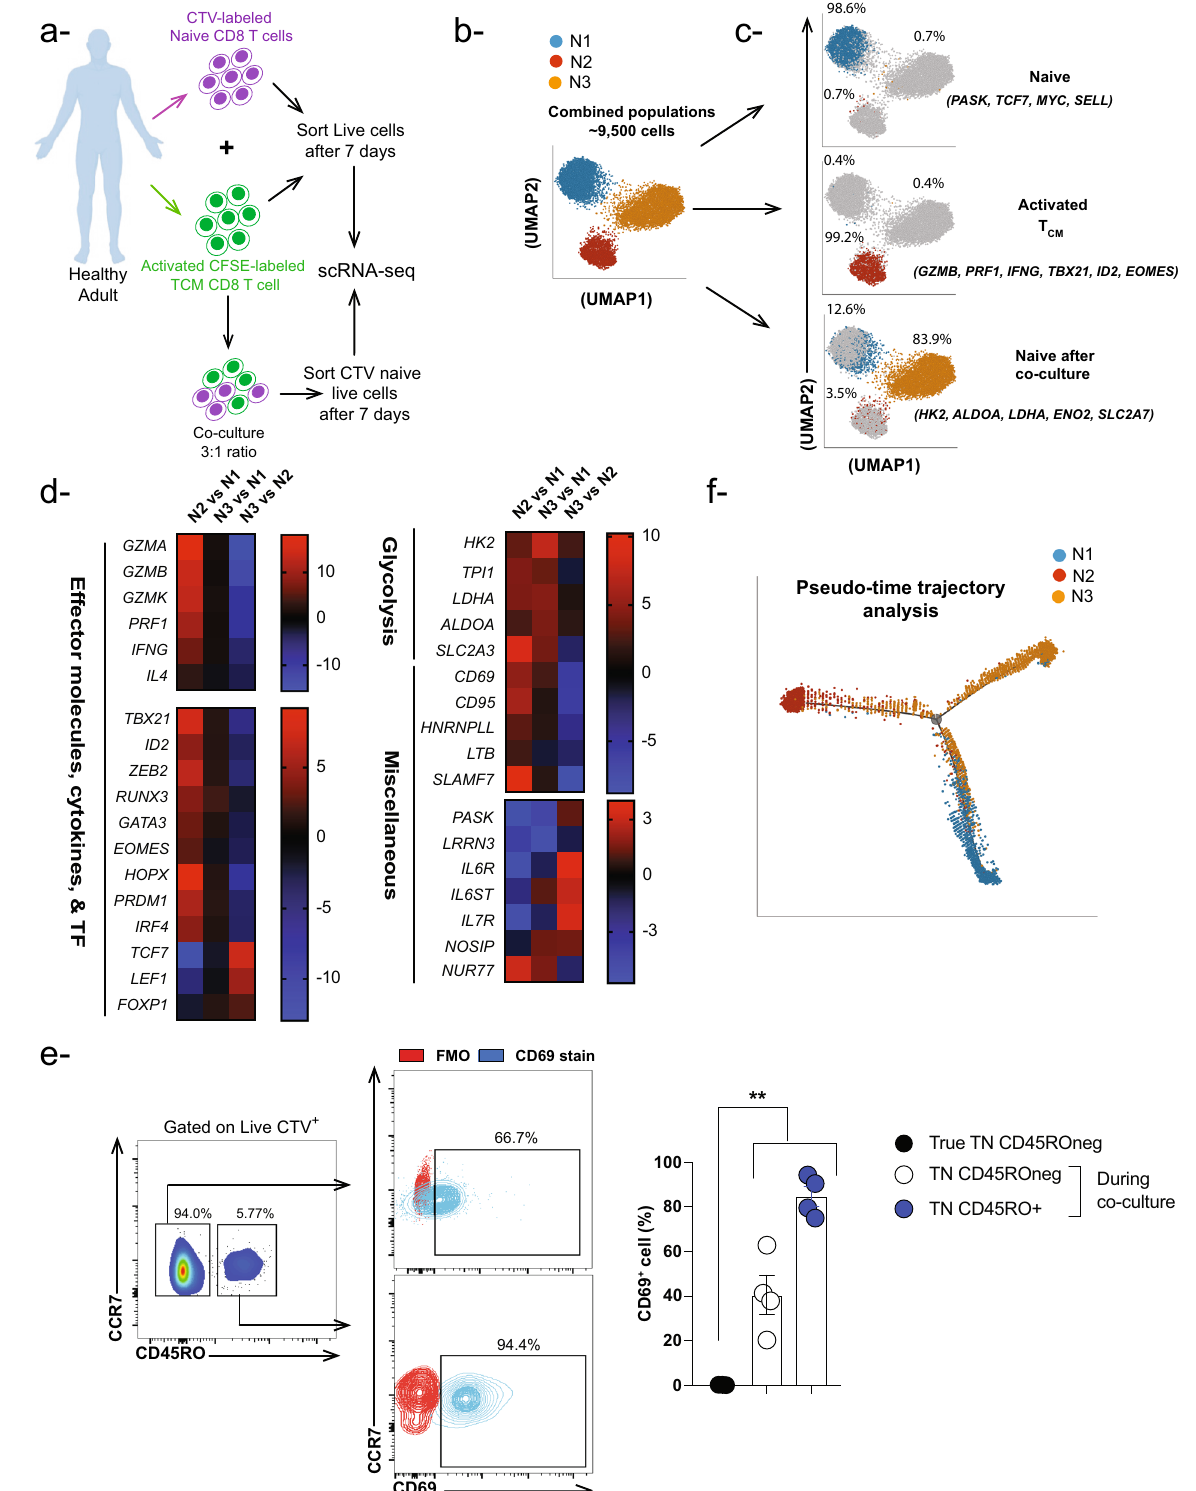
neighborhoods (Fig. 6c). Consistent with the cell surface pheno- typing (Fig. 1), ~3% of naïve cells after co-culture neighbored activated T CM in N2, but only ~13% neighbored naïve T cells in N1 (Fig. 6c). Instead, the highest percentage of naïve cells after co-culture (~84%) localized to a distinct neighborhood, N3, indicating that they underwent transcriptional changes divergent from those that might have occurred in naïve or activated